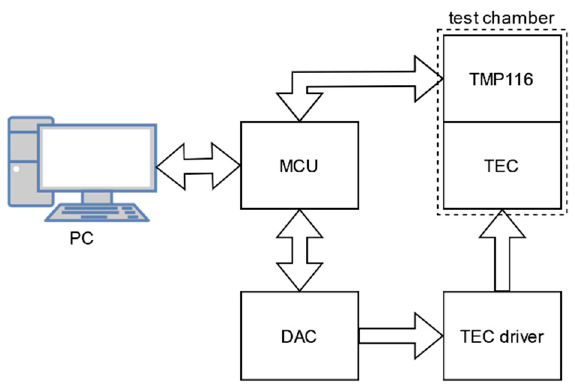
Figure 4. The chamber control system—block diagram.